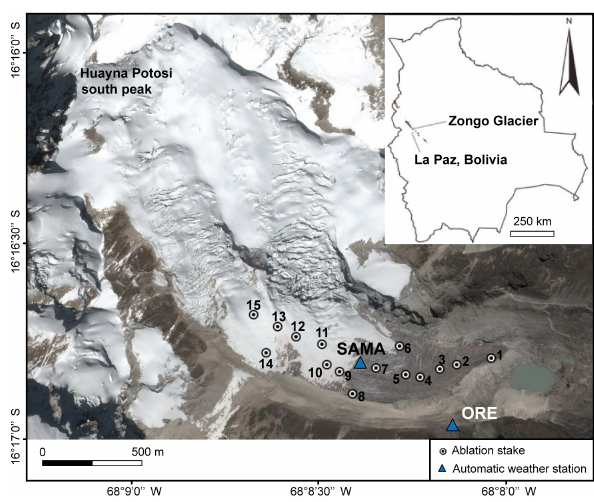
Figure 5. Study site with the Zongo Glacier and the location of the meteorological stations: ORE (5050ma.s.l.) outside of the glacier and SAMA (5056ma.s.l.) on the glacier. The numbers indicate the position of each in situ LCA on ablation